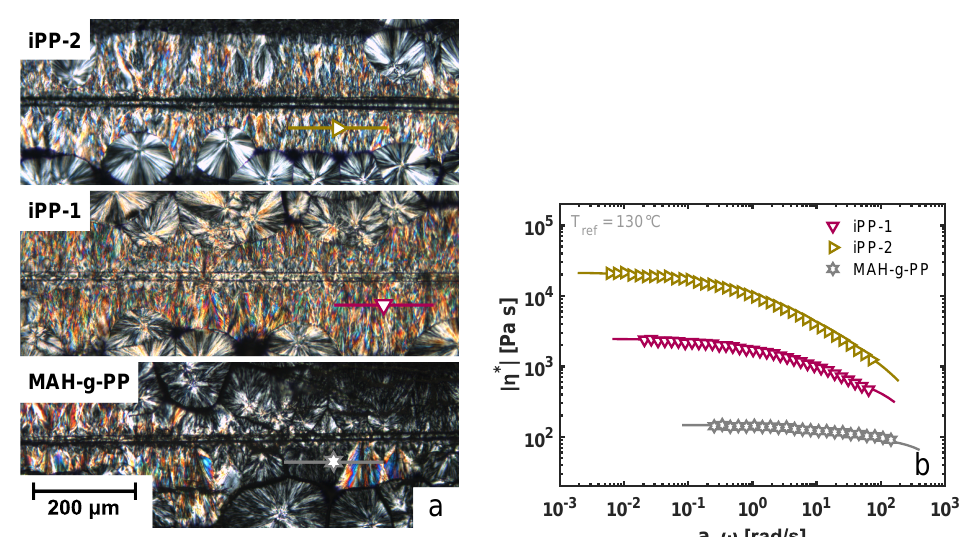
Figure 6. ( a ) Effect of matrix molecular weight on the developed was in a single-fiber composite sample. The horizontal lines indicate the location where a line scan is made to obtain a statistical average for the dichroic difference, i.e., the parameter used to quantify the degree of orientation of the cylindrical layer. ( b ) The complex viscosity as a function of frequency for the different matrix materials under consideration. The lines represent the fitted Maxwell modes that describe the relaxation of these undercooled melts. The model parameters are given in Table S1 of the Supplementary Material.